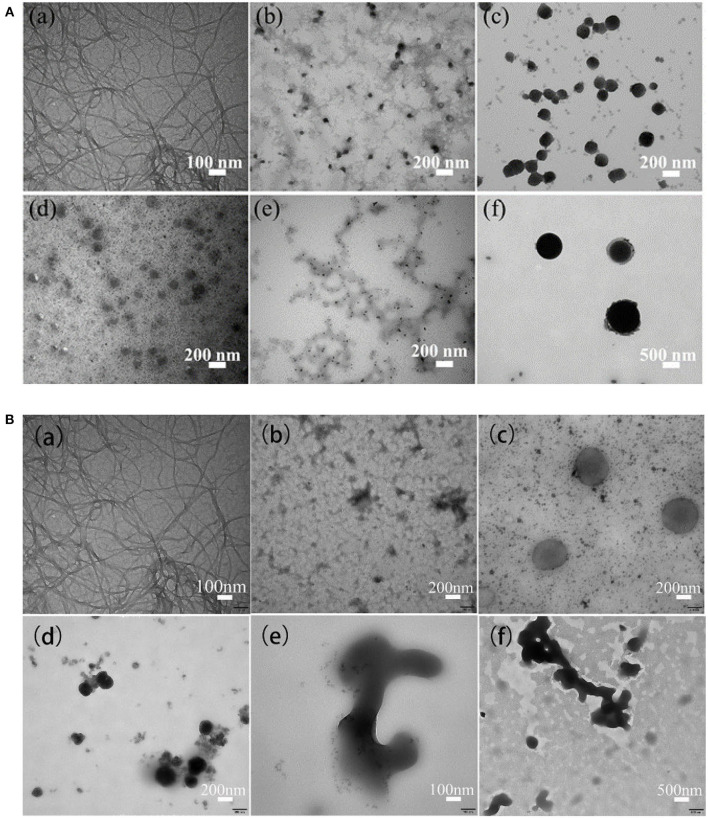
(A) TEM images of ANFs and ANMs-C3H5-X samples: (a) ANFs, (b) ANMs-C3H5-1(10%), (c) ANMs-C3H5-2(20%), (d) ANMs-C3H5-3(50%), (e) ANMs-C3H5-4(100%), (f) ANMs-C3H5-5(200%). (B) TEM images of ANFs and ANMs-C7H8-X samples: (a) ANFs, (b) ANMs-C3H5-1(10%), (c) ANMs-C3H5-2(20%), (d) ANMs-C3H5-3(50%), (e) ANMs-C3H5-4(100%), (f) ANMs-C3H5-5(200%).